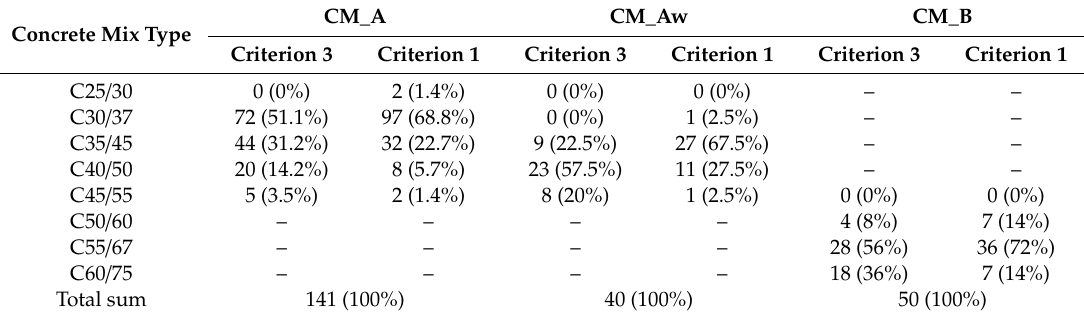
Table 5. Conformity criterion results for concrete mix